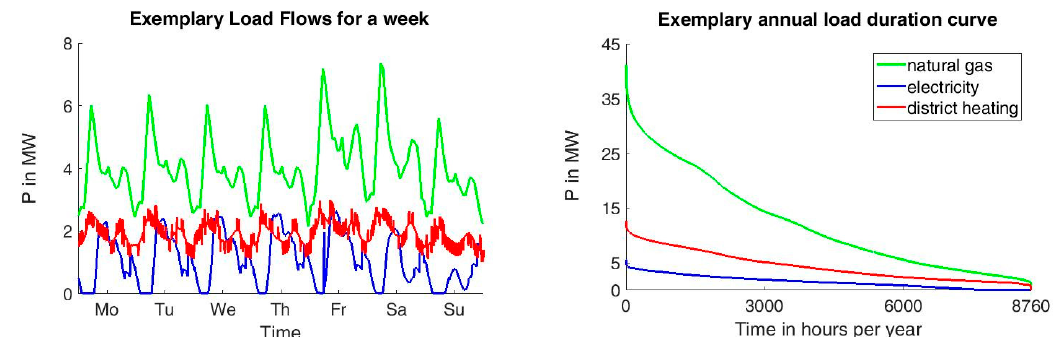
Figure 10. Load duration curves of energy imports/exports for all energy carriers and one year.